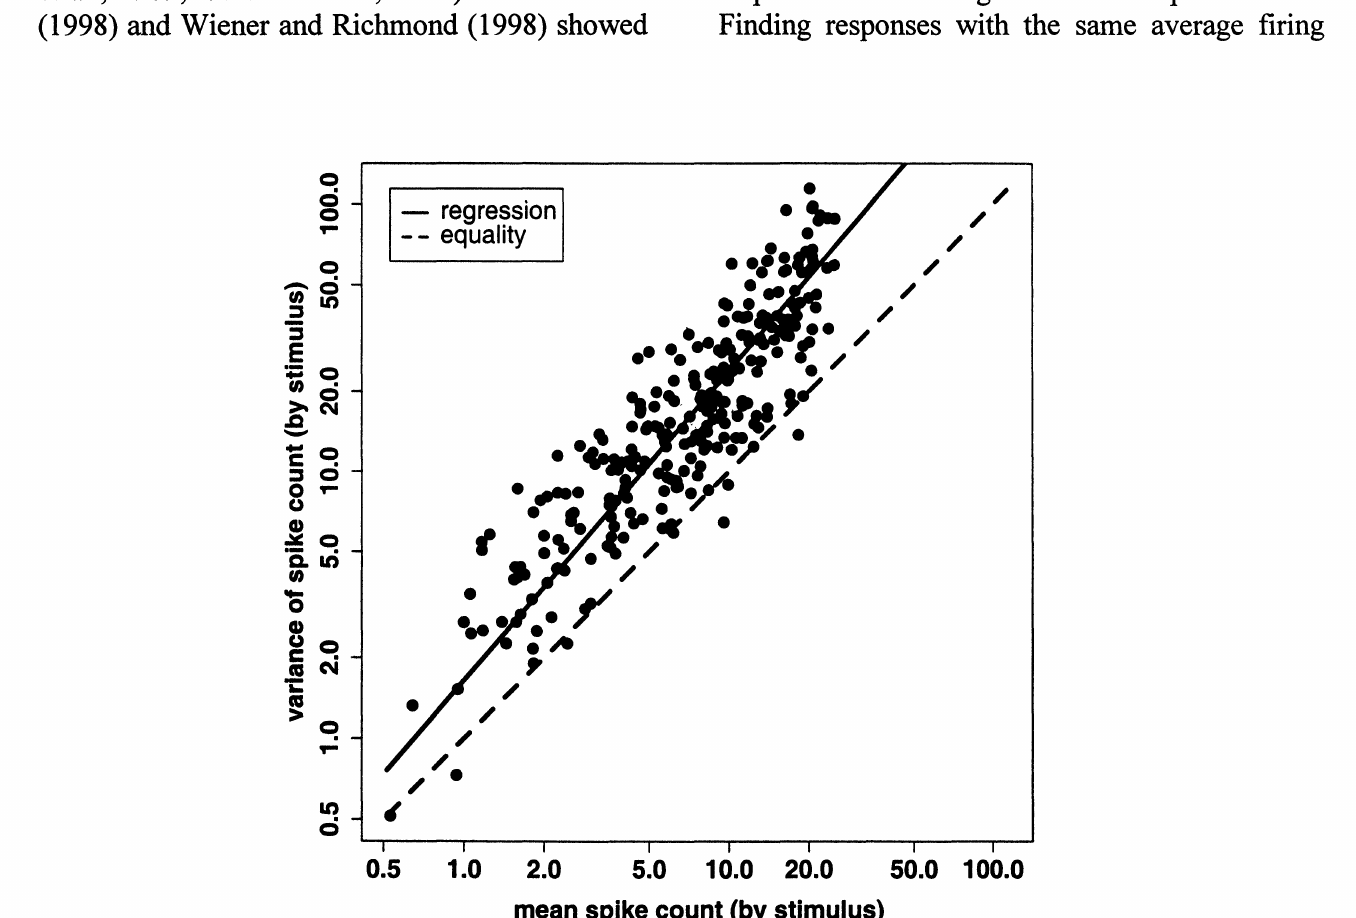
Fig. 1" Relation between mean and variance across all presented stimuli for a single V1 complex cell. Each point shows the mean and variance of spike counts elicited by a single stimulus. The log(variance) is linearly related to the log(mean). The regression line (solid) has a slope of 1.16 and an intercept of 0.5. The data would not be well-approximated by a Poisson process (dotted line). The median variance to mean ratio for these data was 2.3 (interquartile range: 1.7-3.1). The variance to mean ratio for a Poisson distribution would be